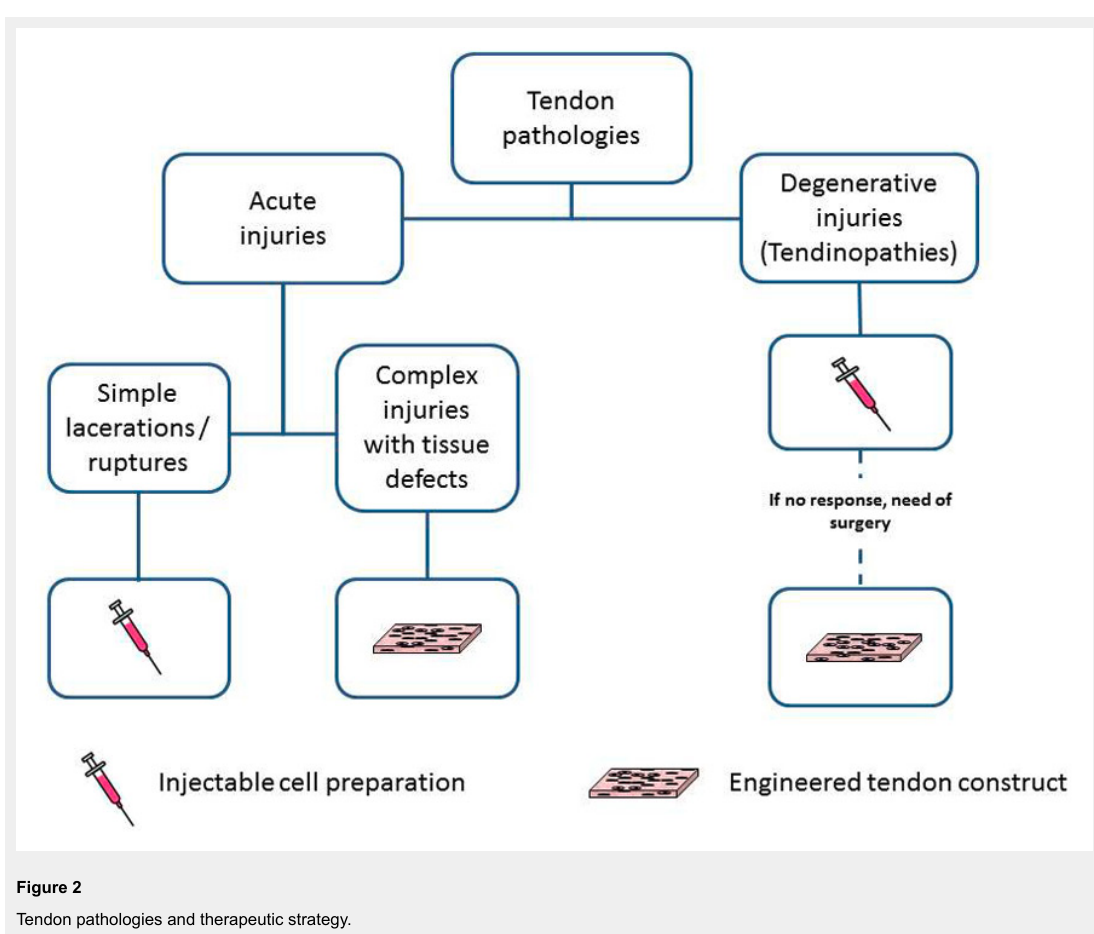
Tendon pathologies and therapeutic strategy. Tendon pathologies can be either acute or degenerative. Degenerative therapies could be treated with biological cellular therapies with injectable forms to delay degenerative responses and more invasive surgery. Acute injuries, depending on their severity, could be treated with either non-invasive to invasive technique with cells in viscous biogels to complex neo-tissue